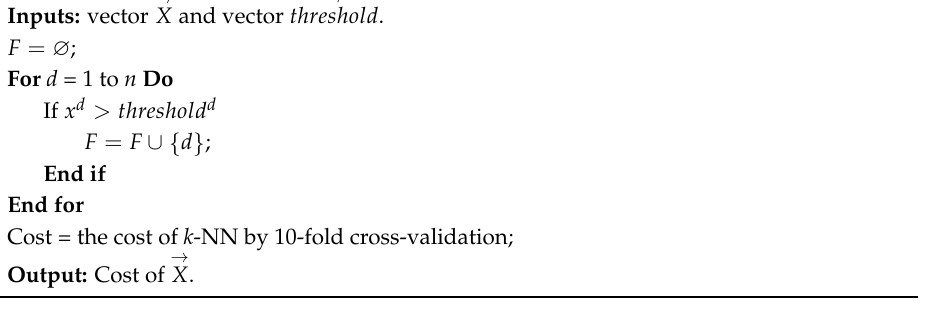
Algorithm 3. Outline of 10 − fold − cost algorithm.